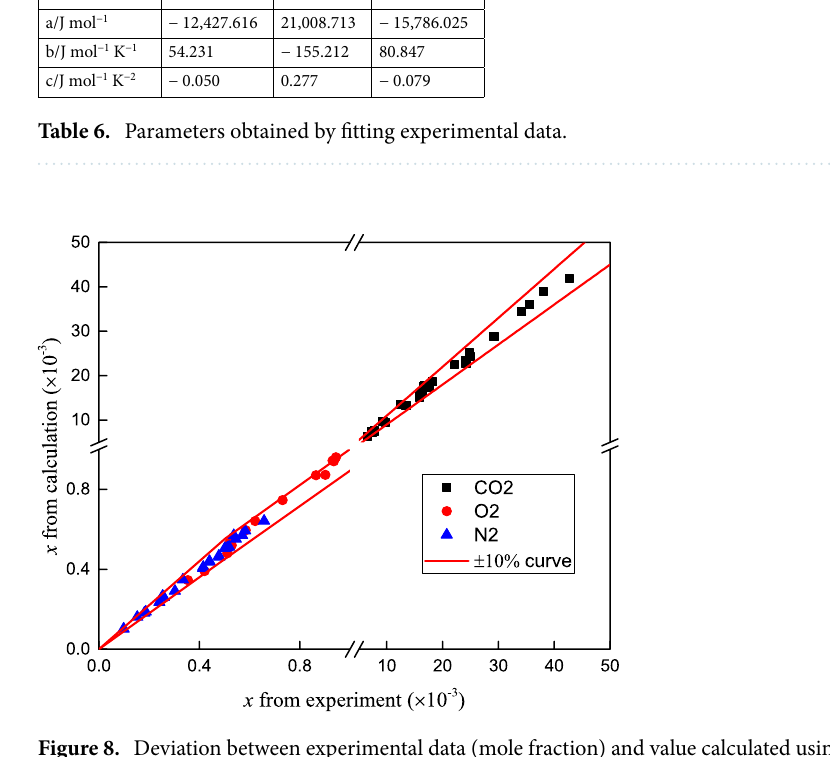
Figure 8. Deviation between experimental data (mole fraction) and value calculated using Eq.